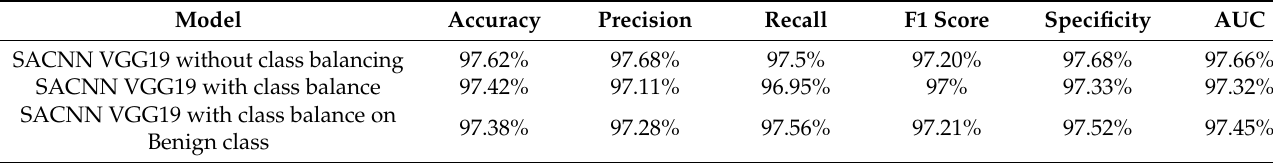
Table 2. Experiment result of our three approaches on SACNN architecture. Model